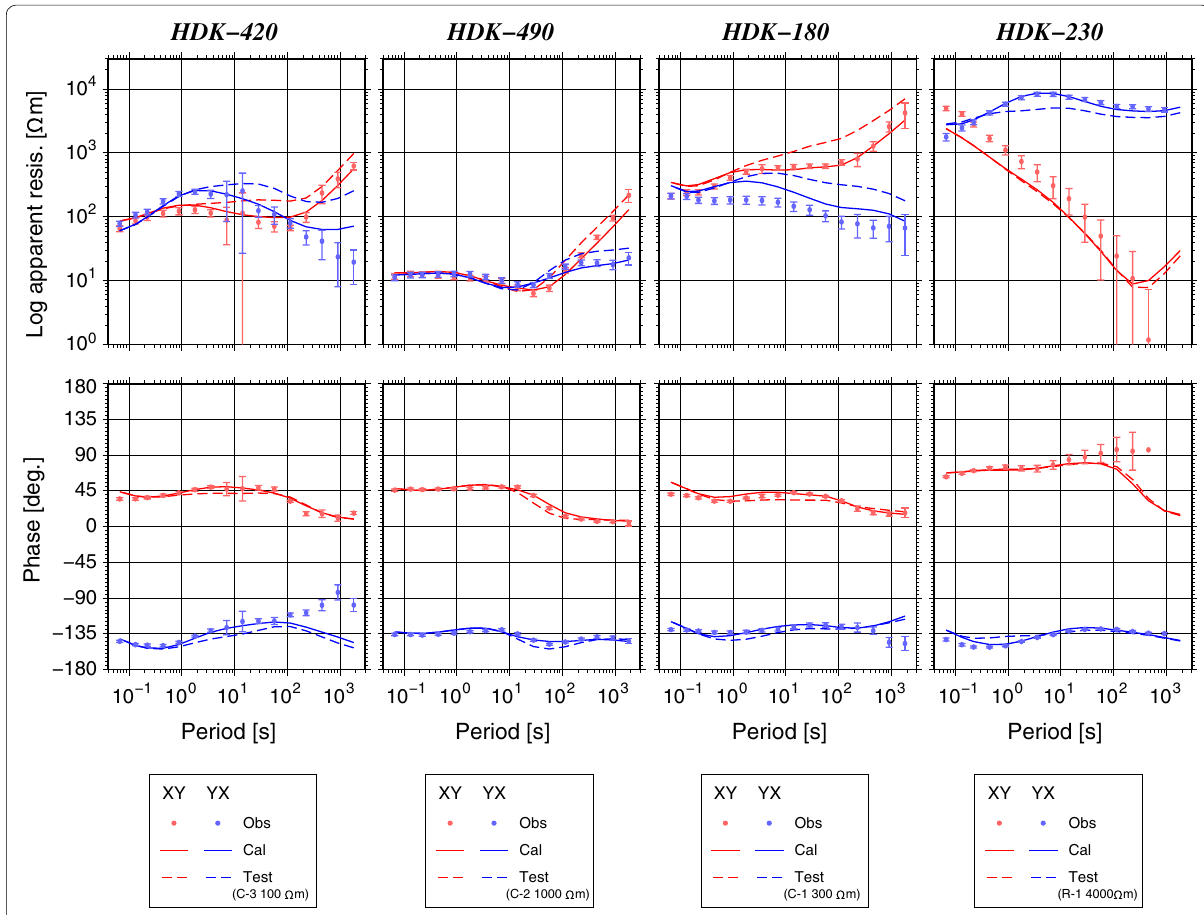
Fig. 2 Sounding curves of MT impedances for sites 420, 490, 180, and 230, including calculated responses of sensitivity tests for anomalies C-3 (station HDK-420), C-2 (HDK-490), C-1 (HDK-180), and R-1 (HDK-230). The error bars include error